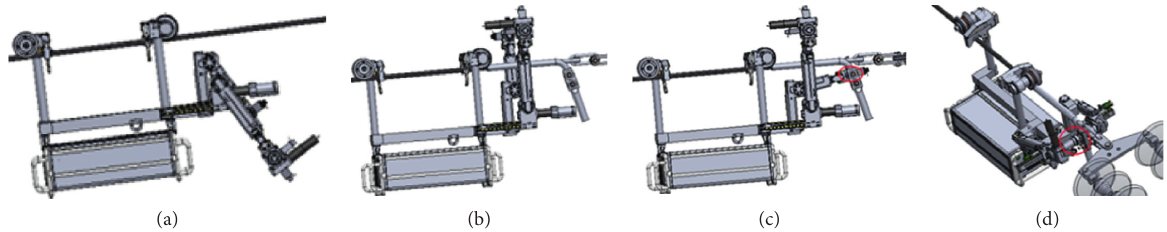
Figure 3: Entity motion simulation of bolt tightening plan for drainage plate. (a) Initial posture. (b) Working posture. (c) Fixing of bolt head. (d) Bolt tightening